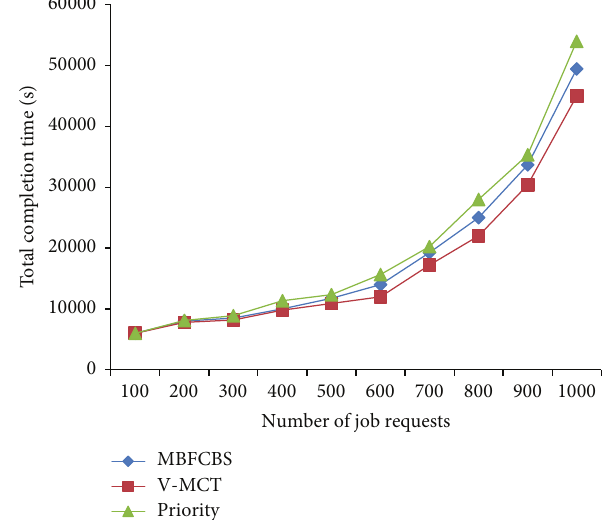
Figure 8: Success rate of scheduling algorithms.